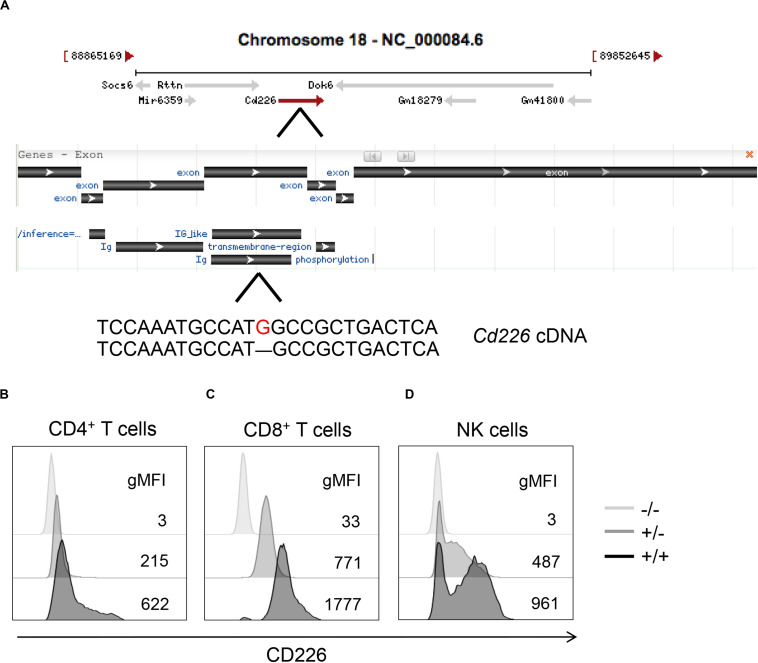
CRISPR/Cas9 targeting methods for generation of CD226 KO strain. (A) A guide RNA was used to target the fourth exon of Cd226, inducing a single base pair deletion (red) that led to a frameshift and premature termination of CD226 protein translation. Modified image from Gene NCBI. Histograms showing CD226 expression in splenic (B) CD4+ T cells, (C) CD8+ T cells, and (D) NK cells of 12-week-old female, pre-diabetic WT (black), HET (gray), and KO (light gray) mice.